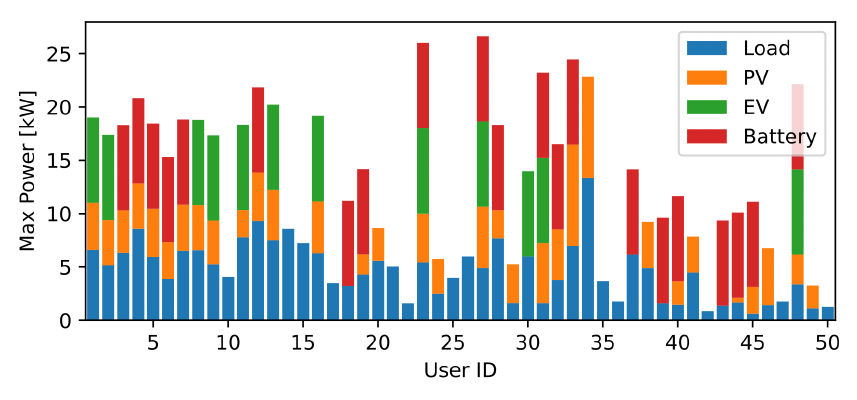
Figure 3. Elements in the 50 residential users (maximum reported